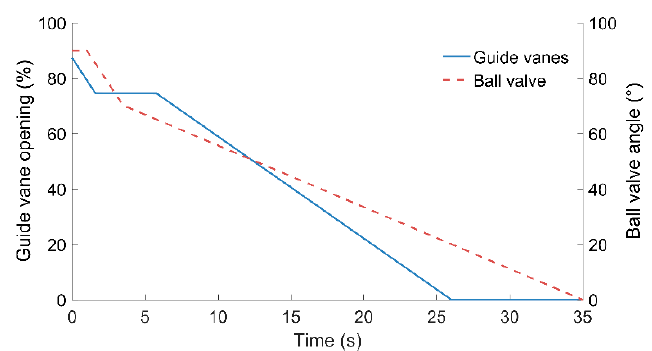
Figure 15. Comparison of optimized closing schemes between subcases in Case 2.